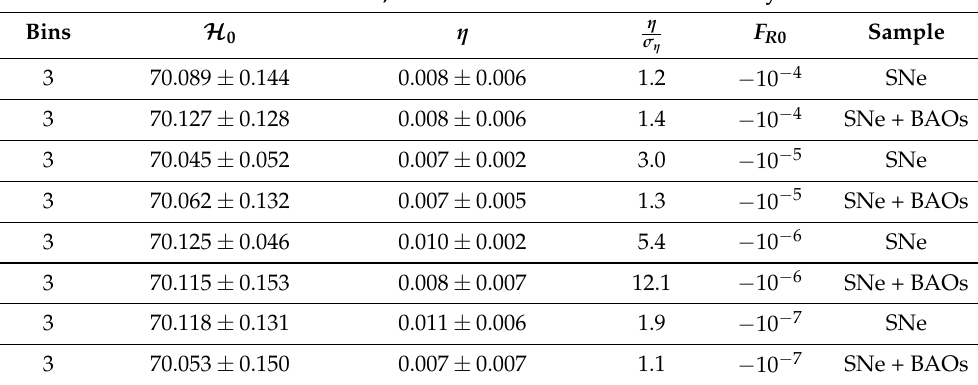
Table 2. Fitting parameters of H 0 ( z ) for three bins within the Hu–Sawicki model, with SNe only and SNe + BAOs with a fixed value of Ω 0 m = 0.298 and with several values of F R 0 : − 10 − 4 , − 10 − 5 , − 10 − 6 , − 10 − 7 . The columns contains: (1) the number of bins; (2) H cording to Equation (9); (4) how many σ s η is compatible with zero (namely, the ratio η / σ η ); (5) F R 0 values; (6) the sample